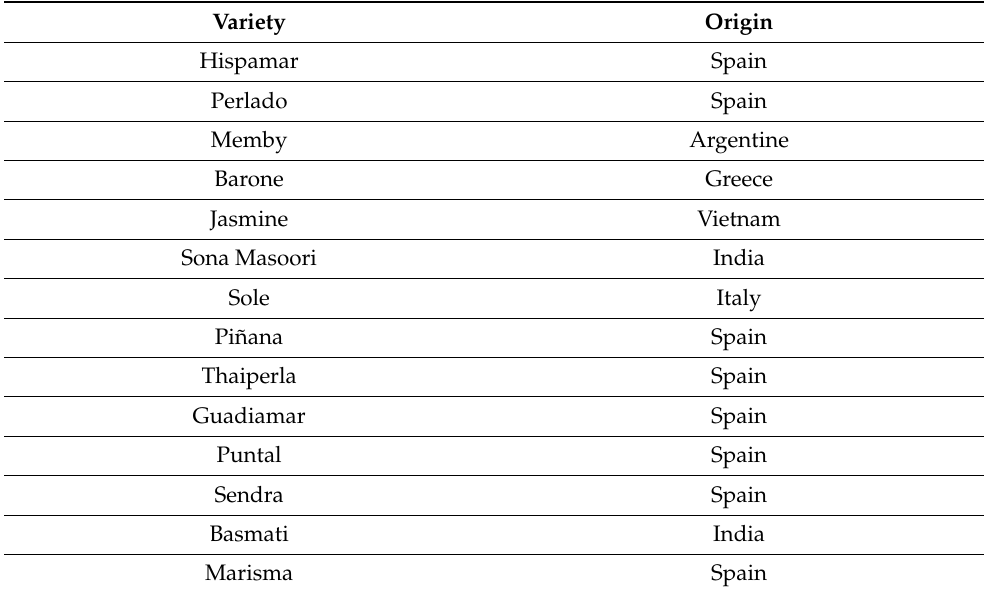
Table 1. Rice samples from different